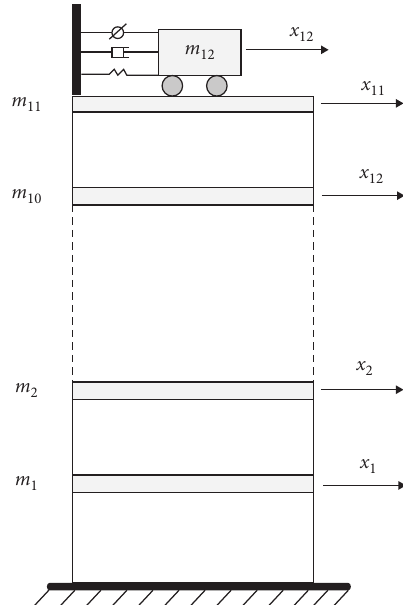
Figure 1: Schematic view of the studied building with vector of the ATMD system responsible for controlling the vibrations of the 11 th story. The term [ D ][ € x g ] denotes the effects of base excitation on the system, where € x g is the acceleration of base excitations and [ D ] � − [ m m , . . . , m , m ] T . The nominal matrix values for [ M ] , 3 11 12 [ K ] , and [ C ] are also presented in the following. However, note that uncertainty will be also considered for these values later in the control design process.